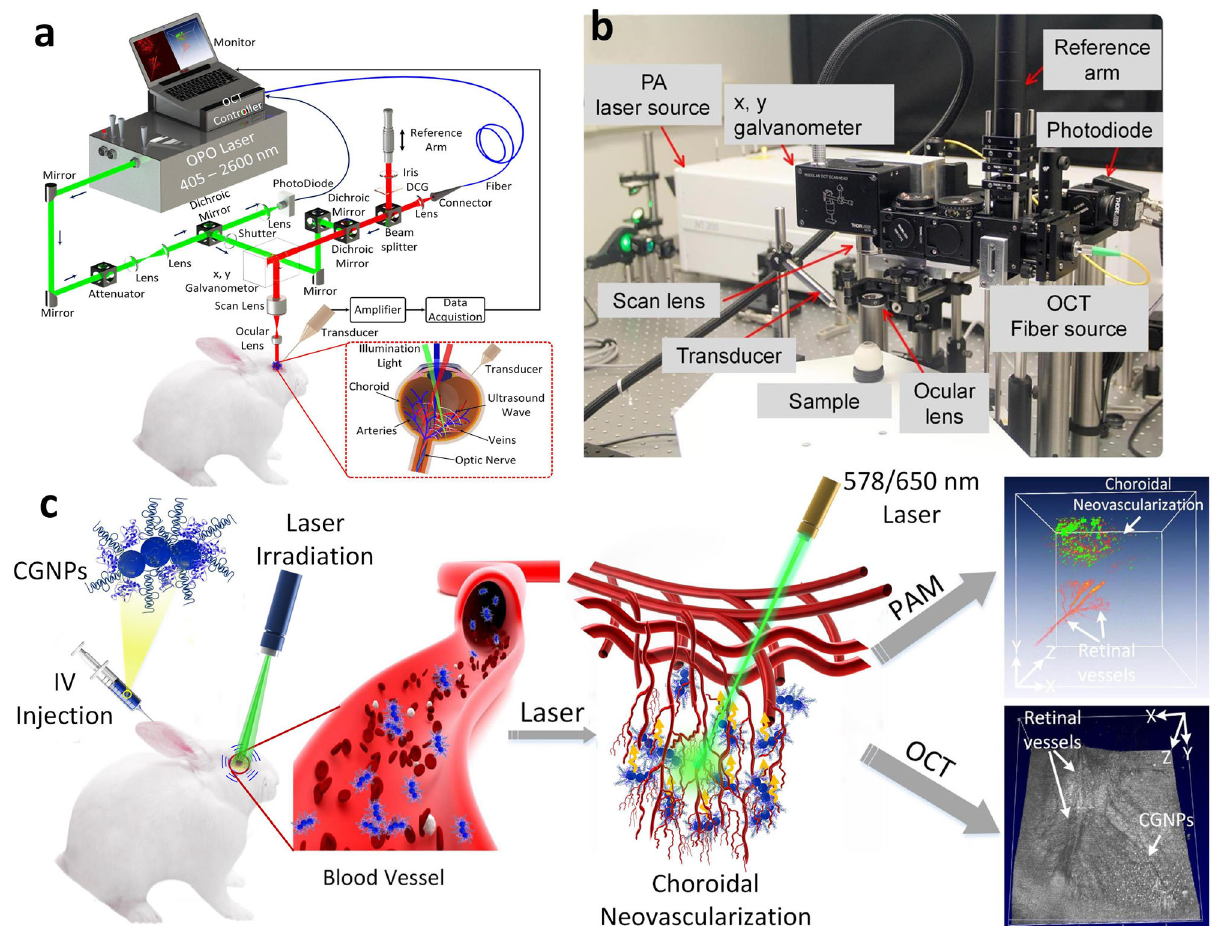
Fig. 3 Experimental setup of multimodal PAM and OCT equipment. a Schematic diagram of the imaging system. b Physical setup. In PAM mode, nanosecond excitation laser with tunable wavelength output in 450 – 710 nm range was delivered and focused onto the retina. In addition, to enable multimodal imaging, the excitation laser beam used to induce PA signal was coaxially aligned with OCT multispectral luminescence with a center wavelength at 805 nm and 905 nm (OCT). A needle-shaped hydrophone ultrasonic transducer was used to detect the generated acoustic signal and then, the recorded data was utilized to reconstruct PAM images. The re fl ected OCT light interfered with the reference light and the interference intensity spectra was detected by a spectrometer. As the retina was scanned by a galvanometer, the acquisition time is approximately 65 s for a fi eld of view of 4 × 4 mm with a resolution of 256 × 256 pixels and the 3D volumetric visualization was rendered. c Illustration of the in vivo multimodal imaging using CGNP clusters-RGD. The synthesized CGNP clusters-RGD were intravenously injected into the rabbit model through marginal ear vein. PA signals from the rabbit retina was generated by using nanosecond pulsed laser illumination at wavelength of either 578 or 650